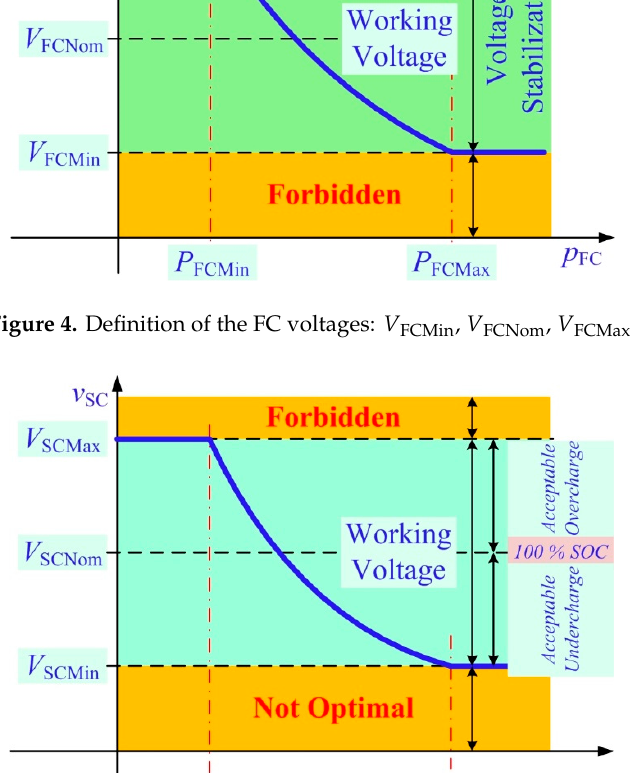
SCMax , V SCMin , V SCNom